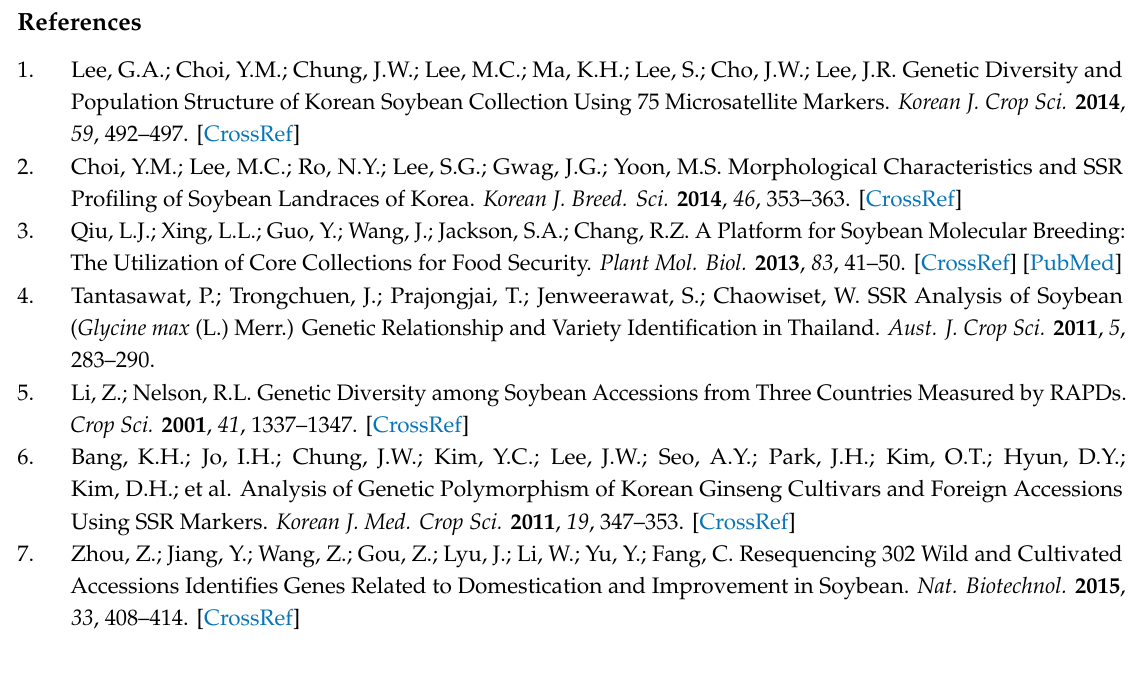
Table S1: Number of soybean varieties classified by released year and breeding organization for this experiment, Table S2: Information of band size (bp) based on 20 markers for SSR analysis in 172 Korean soybean varieties, Figure S1: Principal coordinate analysis (PCoA) plot of 172 Korean soybean varieties using 20 SSR markers, Figure S2: Discrimination of varieties at each step by UPGMA dendrogram using six markers in 172 Korean soybean